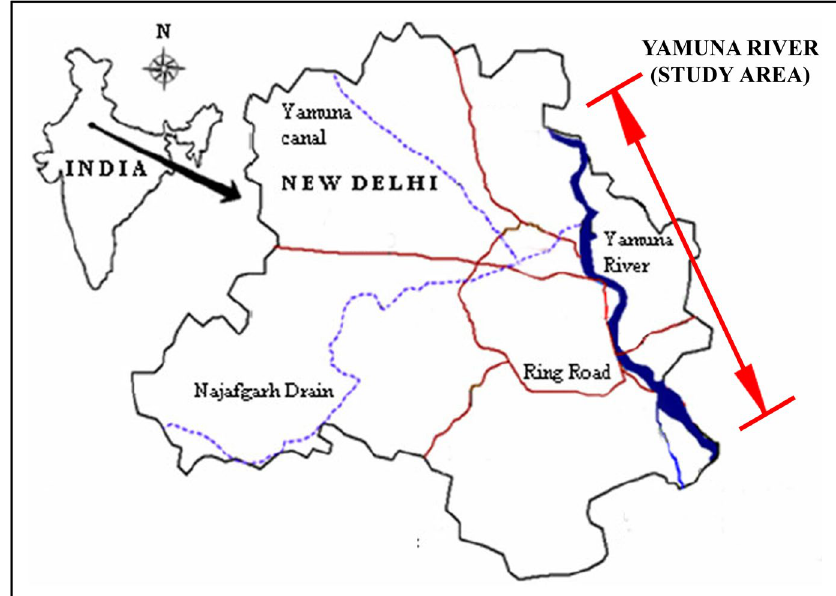
Fig. 1 Location map of the study area (map not to scale)